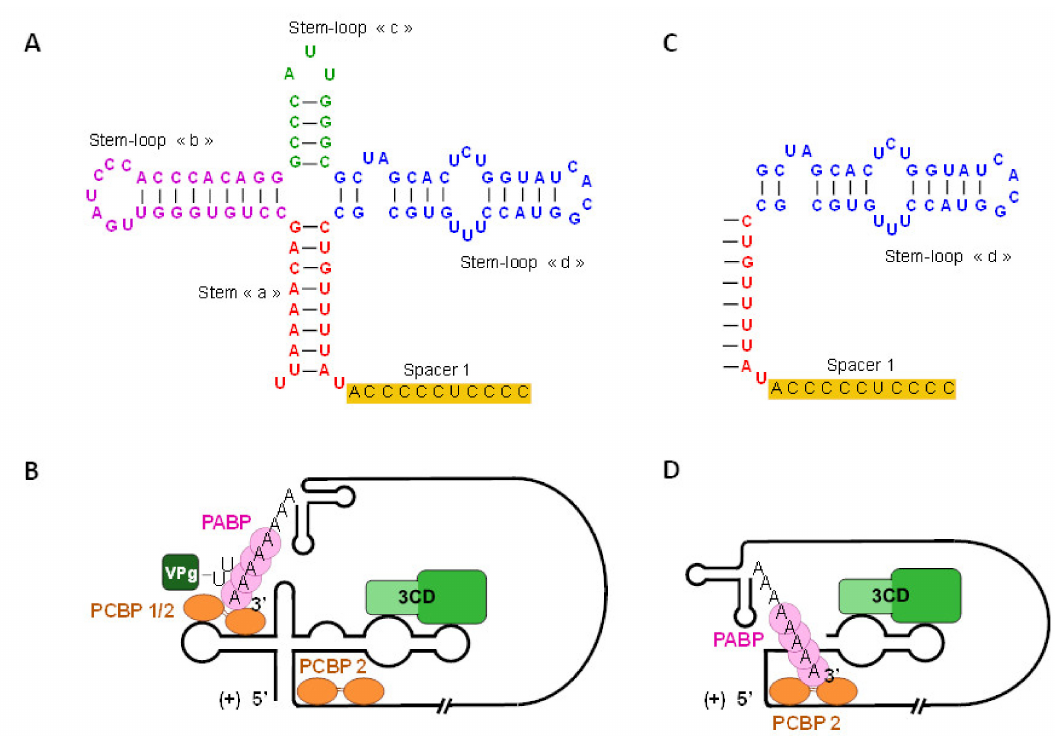
Figure 4. Natural 5 (cid:48) terminal deletions in RNA domain-I disrupt viral ribonucleoprotein complexes involved in group-B enterovirus replication activities. ( A ) Schematic representation of the complete predicted 5 (cid:48) end Cloverleaf secondary structures (CL, stem-loop I) of the enteroviral positive-strand RNA. The CL is composed of a stem “a” (nucleotides 2–9 with nucleotides 80–87), stem-loop “b” (nucleotides 10–34), stem-loop “c” (nucleotides 35–45), and a stem-loop “d” (nucleotides 46–79). ( B ) Host cellular protein PABP interacts with the poly(A) tail in the viral genome 3 (cid:48) end, PCBP 1 / 2 bind to the stem-loop “b” of the Cloverleaf and in addition, PCBP 2 binds to the spacer 1 at the end of the Cloverleaf. Viral precursor protein 3CD interacts with stem-loop “d” of the Cloverleaf. ( C ) Schematic representation of the 5 (cid:48) terminally deleted Enterovirus RNA with 50 nucleotides deletions in Cloverleaf secondary structures. ( D ) 5 (cid:48) terminal deletions in RNA domain-I disrupts the formation of viral ribonucleoprotein complexes: PABP interacts with the 3 (cid:48) end poly(A) tail, PCBP 2 binds to the spacer 1 at the end of the Cloverleaf, and the precursor 3CD interacts with stem-loop “d” of the Cloverleaf. This loss of interactions with viral protease and cellular factor in stem-loop “b” alters EV-B replication